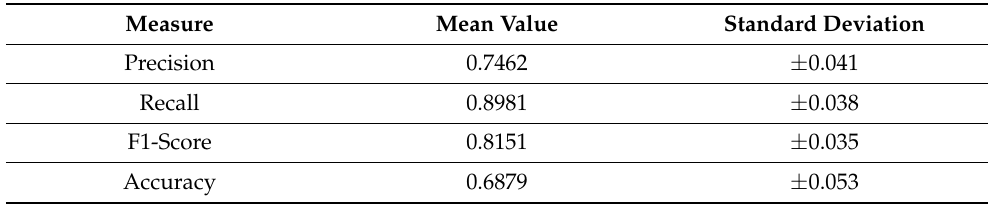
Table 2. Statistical significance test